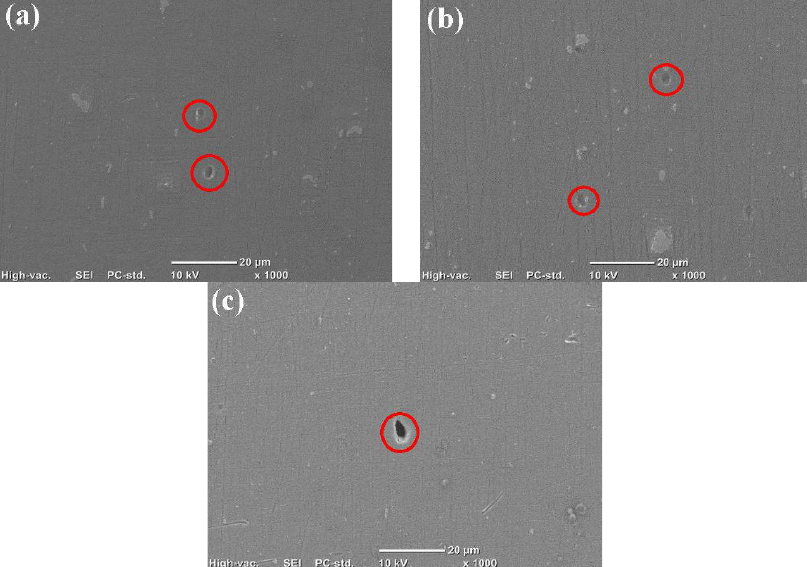
Figure 6. Scanning electron microscope (SEM) images for evolution of microvoid in AA7050 during creep aging under 165 °C and 350 MPa: ( a ) 1 h; ( b ) 2 h; and, ( c ) 3 h.